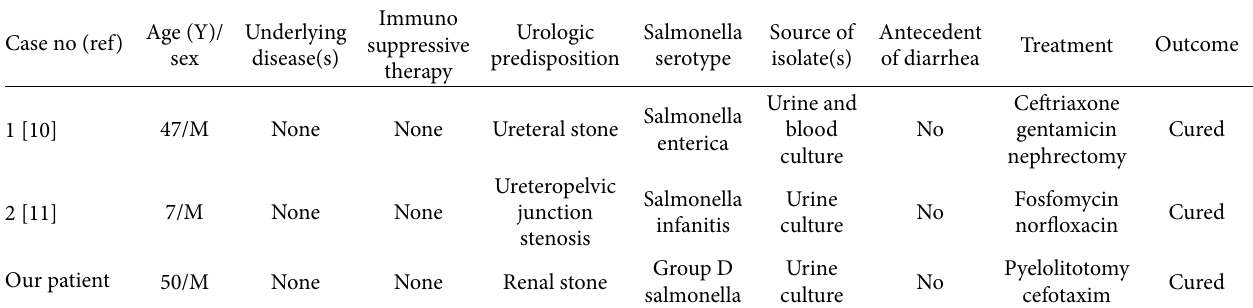
Table 1: Characteristics of patients with pyonephrosis due to non typhoidal